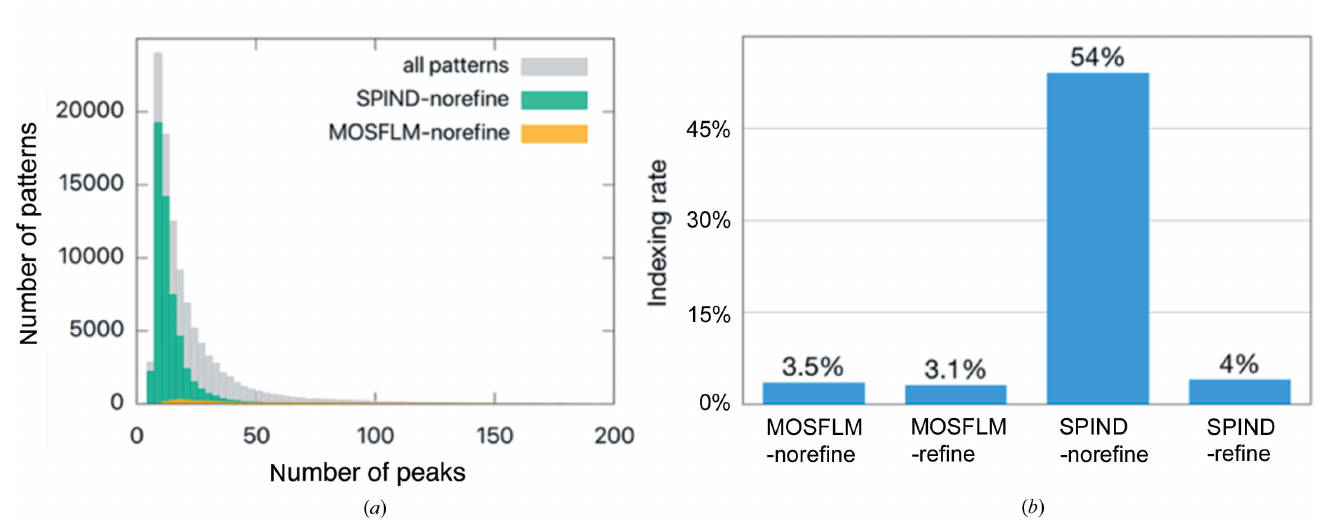
Figure 7 Statistics of ClR data set. ( a ) Distribution of number of peaks per pattern. Most patterns contained ten to 30 peaks, and were not indexed using MOSFLM (gray bars, (cid:8) 100 000 patterns). Histograms from SPIND -refine and MOSFLM -refine fit within the yellow distribution and are omitted for clarity. ( b ) Comparison of indexing rates using MOSFLM and SPIND with the lattice-refinement option in indexamajig enabled and disabled. The lattice-refinement feature requires that more than ten found peaks match their predicted peak positions with a small excitation error (that increases smoothly with resolution) (White, Barty et al. , 2016). Patterns are discarded (not indexed) if this criterion is not met. This contributes to the abrupt cut in indexing rate from using SPIND -norefine to SPIND -refine since this data set consists of a significant portion of patterns with few peaks (fewer than five).